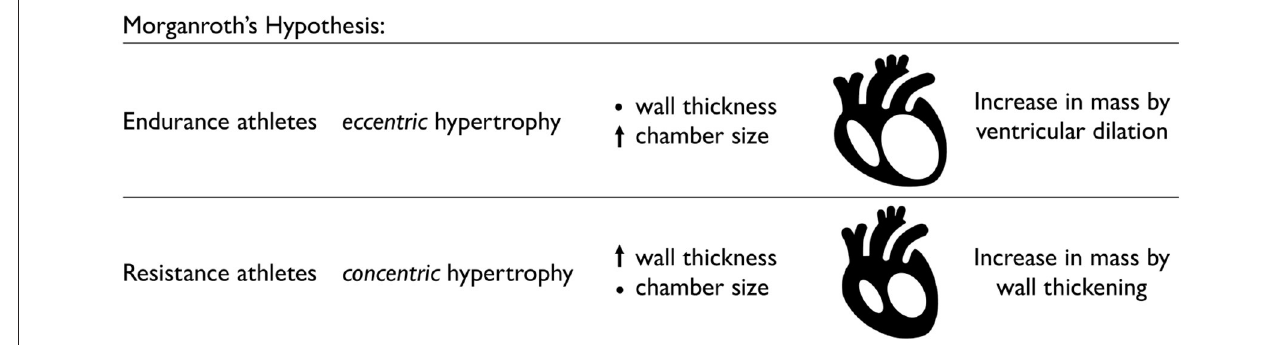
FIGURE 3 | Physiological adaptation in endurance and resistance athletes. According to Morganroth’s hypothesis, endurance athletes tend to develop eccentric hypertrophy associated with ventricular dilation caused by volume overload, while the wall thickness remains relatively constant. Resistance athletes tend to develop concentric hypertrophy associated with ventricular wall thickening caused by pressure overload, while the chamber size remains relatively constant.